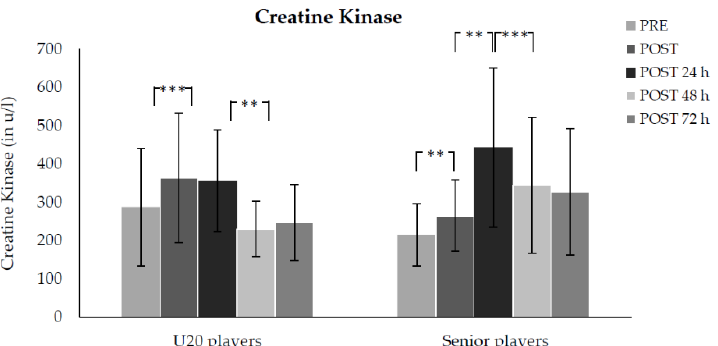
Figure 3. Mean CK value as a function of measurement time point (PRE, POST, POST 24 h, POST 48 h, POST 72 h) for U20 and senior handball players. The error bars represent standard deviations (* p < 0.05, ** p < 0.01, *** p < 0.001).